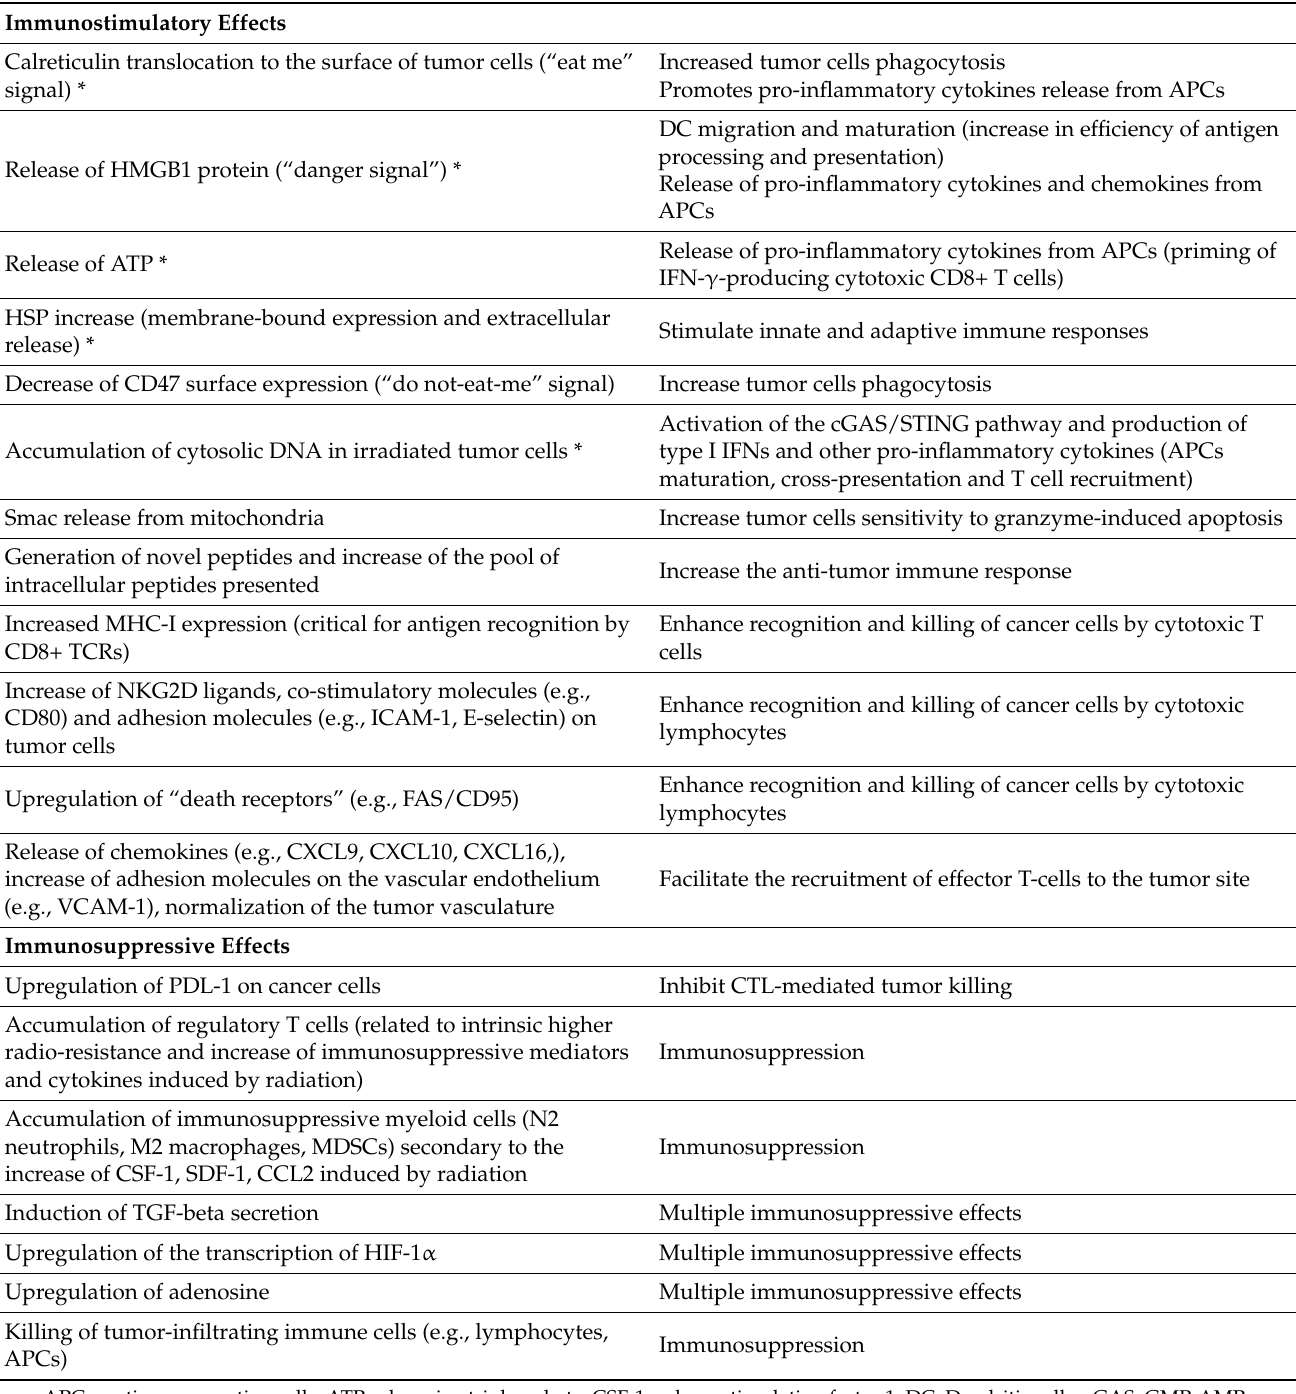
Table 3. Immunogenic effects of radiotherapy